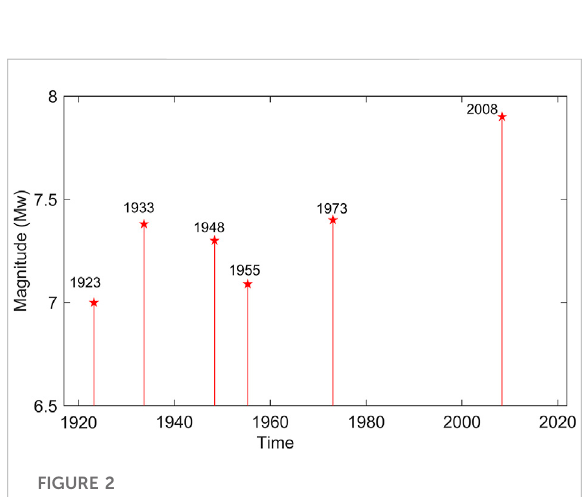
FIGURE 2 Earthquakes of Mw ≥ 7.0 that occurred within a 300 km radius of the epicenter of the 12 May 2008 Sichuan earthquake of Mw 7.9 since